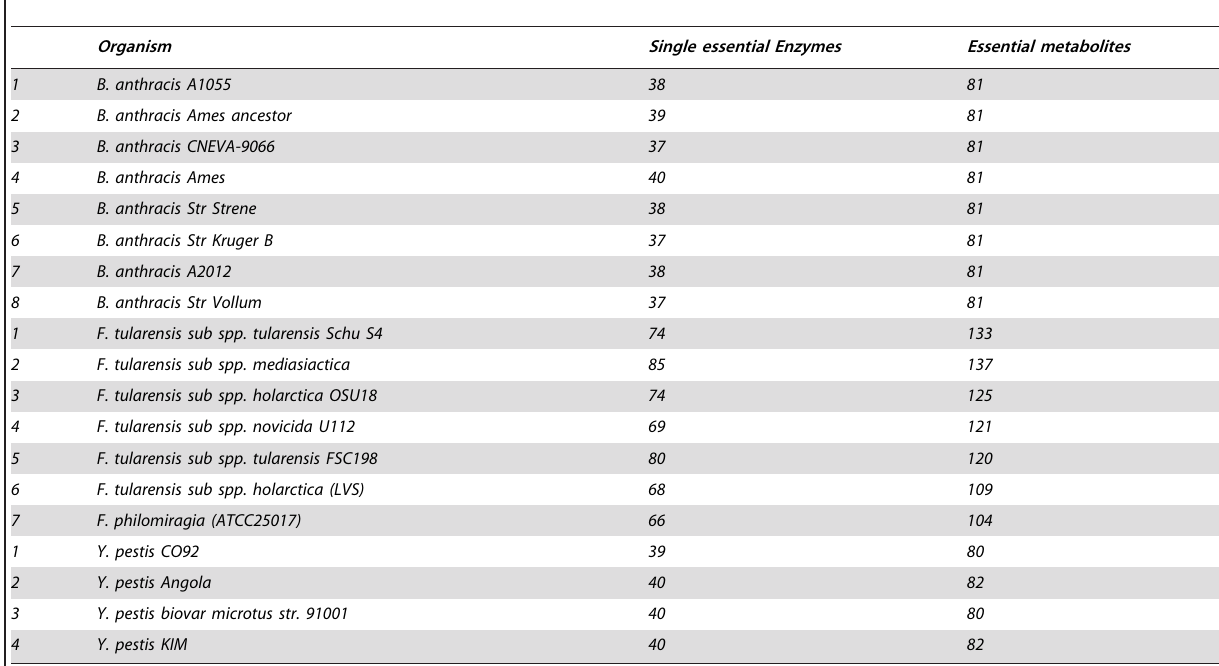
Table 2. Single essential enzymes and metabolites in the indicated strains identified using FBA for each of the strains studied.